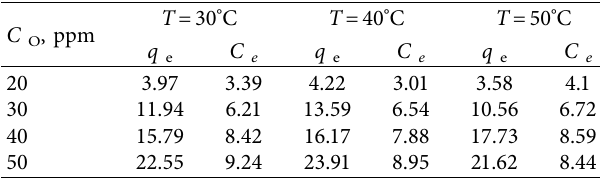
O , ppm, and q e , mg/g values obtained at varying concentration and temperatures.